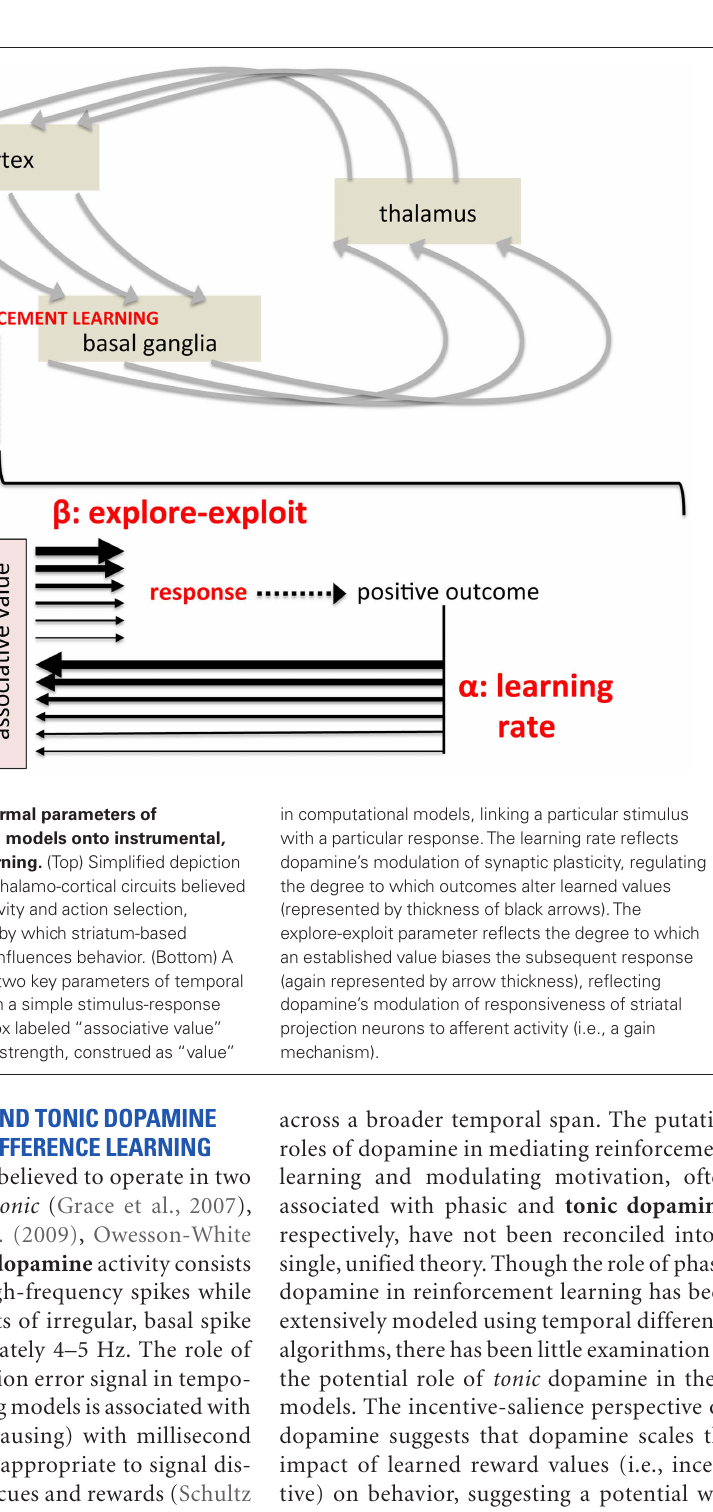
in computational models, linking a particular stimulus with a particular response. The learning rate reflects dopamine’s modulation of synaptic plasticity, regulating the degree to which outcomes alter learned values (represented by thickness of black arrows). The explore-exploit parameter reflects the degree to which an established value biases the subsequent response (again represented by arrow thickness), reflecting dopamine’s modulation of responsiveness of striatal projection neurons to afferent activity (i.e., a gain